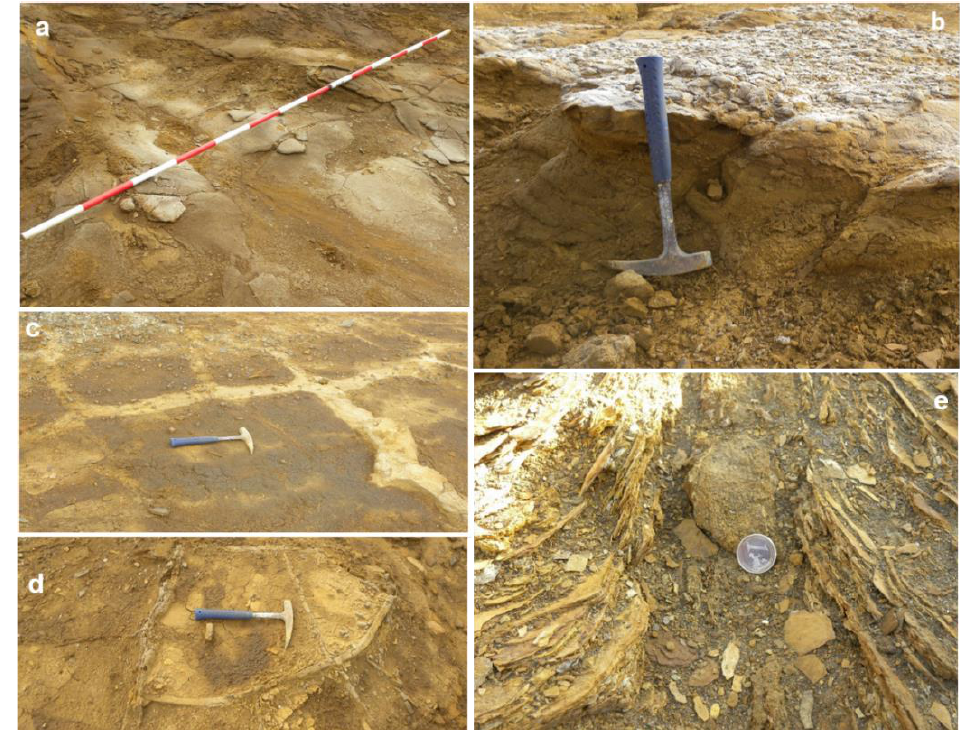
Figure 7. ( a ) Massive sandy layer in the lagoon one (Lg1). ( b ) Detail of the atypical stratification of sand volcanoes compared with stratigraphic signature of mining tailings. ( c ) Sand dikes in lagoon one (Lg1). ( d ) Sand dikes in landslide one (LL1). ( e ) Detail of the sand dike emplacement, which cut crosses the subhorizontal tailings bedding.